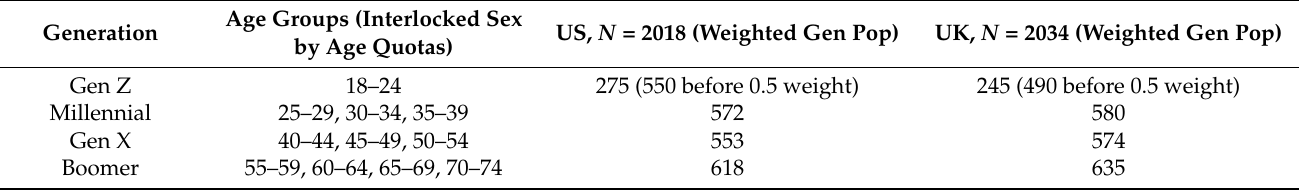
Table 1. Representative sampling